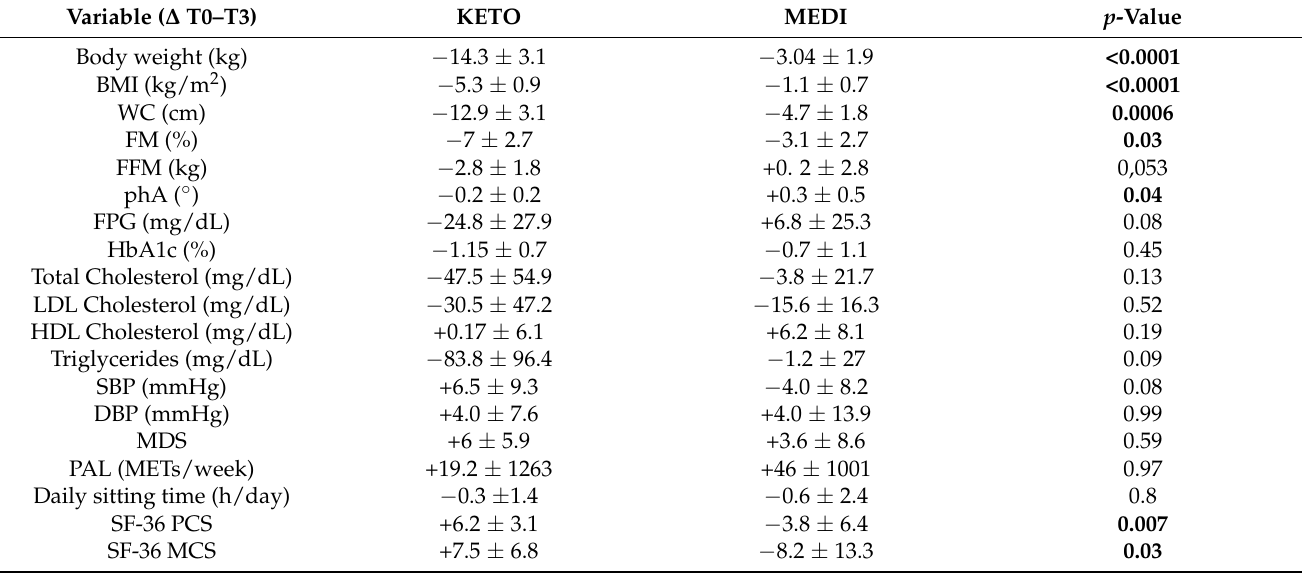
Table 3. Anthropometric, metabolic, lifestyle, and health status T0–T3 variations in KETO and MEDI